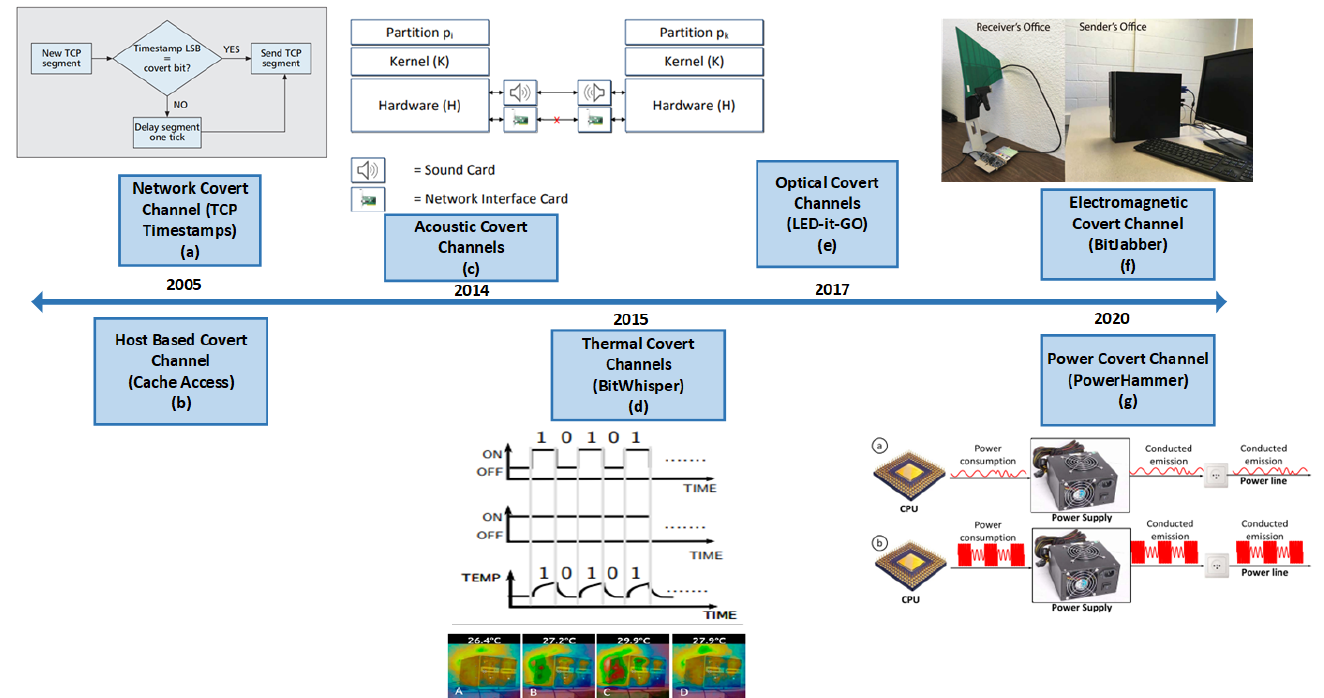
Figure 2. Timeline of various network-based, host-based and physical covert channels ( a ) TCP timestamps [28], ( b ) Cache Access [24], ( c ) acoustic channels [30], ( d ) Bitwhisper [33], ( e ) Led-it- GO [34], ( f ) BitJabber [31], ( g ) PowerHammer